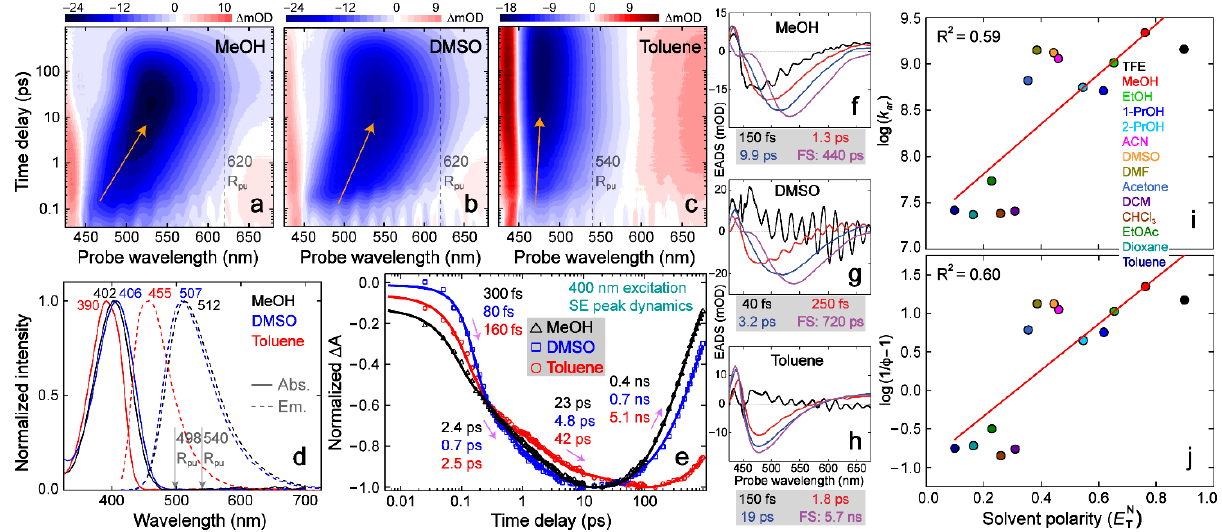
Figure 2. Steady-state and excited-state electronic spectroscopy of C481 in various solvents. Semilogarithmic contour plots of fs-TA spectra for C481 in ( a ) MeOH, ( b ) DMSO, and ( c ) Toluene after 400 nm excitation. The color bar is shown in the milli-optical density (mOD) unit. Orange arrows highlight the stimulated emission (SE) signal intensity magnitude increase and peak redshift. The Raman pump wavelengths for excited-state FSRS measurements are denoted by vertical dashed gray lines. ( d ) Steady-state absorption (Abs., solid) and emission (Em., dashed) spectra of C481 in three solvents: MeOH (black), DMSO (blue), and Toluene (red). The Raman pump wavelengths for ground-state FSRS measurements are denoted by vertical gray arrows at 498 nm for C481 in Toluene and 540 nm for C481 in MeOH and DMSO. ( e ) Probe-dependent TA signal at the SE peak region (data points) with multi-exponential least-squares fits (solid lines) that are color-coded with three solvents. The retrieved time constants are listed by their associated dynamic components. The evolution-associated difference spectra (EADS) of fs-TA spectra of C481 in ( f ) MeOH, ( g ) DMSO, and ( h ) Toluene with the retrieved lifetimes color-coded and listed below each panel. FS: fluorescent state. The base 10 logarithmic plots of ( i ) nonradiative rate constants 𝑘 (cid:3041)(cid:3045) and ( j ) ratios of 𝑘 (cid:3041)(cid:3045) over 𝑘 (cid:3045) (i.e., (cid:2869) − 1 ) against the solvent polarity parameter (color-coded for 14 solvents). The adjusted R 2 values are listed in the insets to reflect the quality of linear correlation.